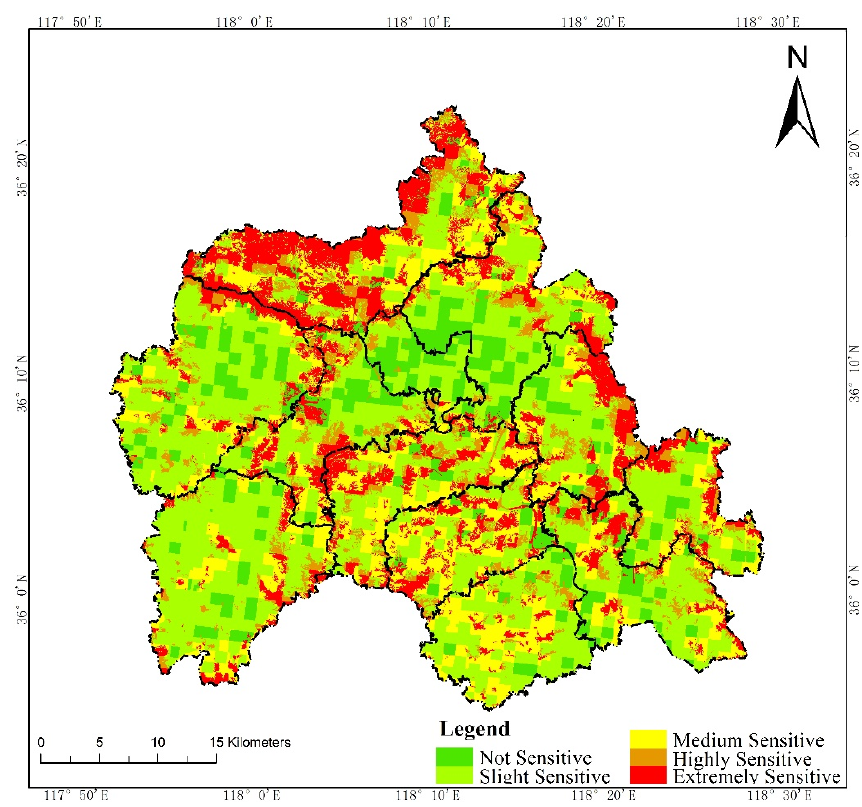
Figure 3. Evaluation of sensitivity level of ecological environment.